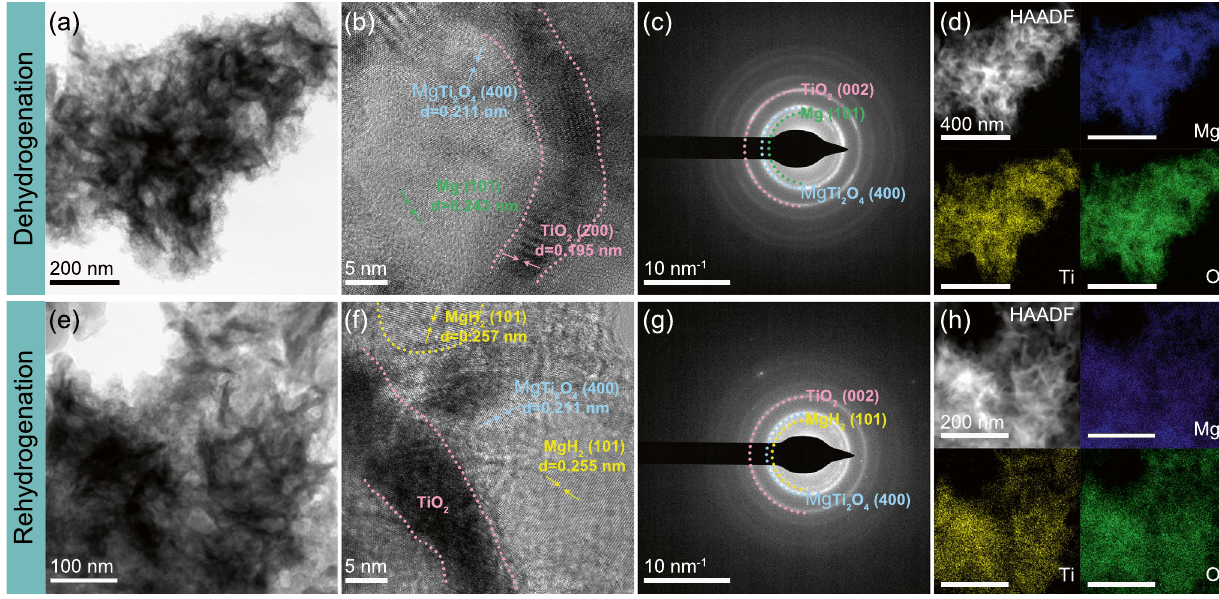
Fig. 5 BF, HRTEM, SAED, HAADF images as well as EDS elemental mapping results of dehydrogenated a‑d and re-hydrogenated e–h 60MgH 2 /TiO 2